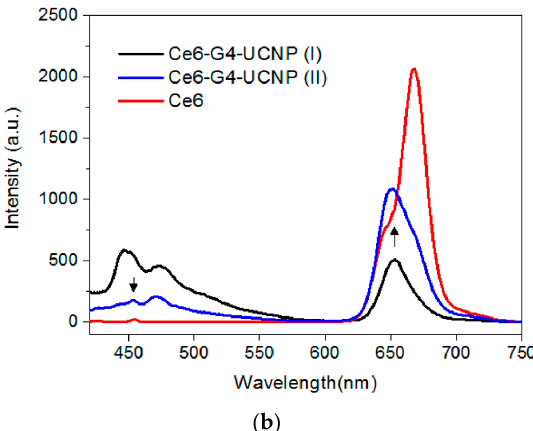
Figure 3. ( a ) UV-Vis absorption; and ( b ) fluorescence spectra of the hybrid nanoparticles sequentially encapsulated with dendrimers (G4-UCNP) and Ce6 (Ce6-G4-UCNP) in comparison with that of pristine Ce6; (I) and (II) denote different loading capacity of Ce6.